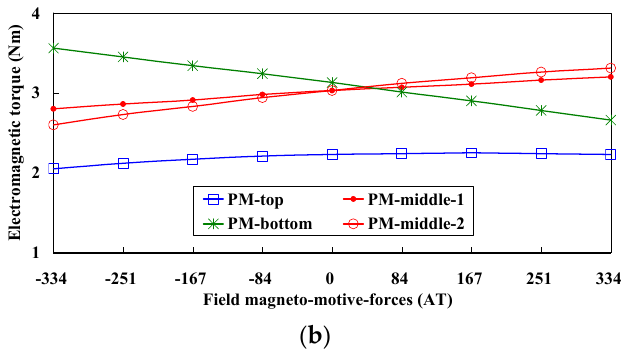
Figure 7. Variation of average torque values by different field currents. ( a ) Employing ferrite; ( b ) Employing NdFeB.